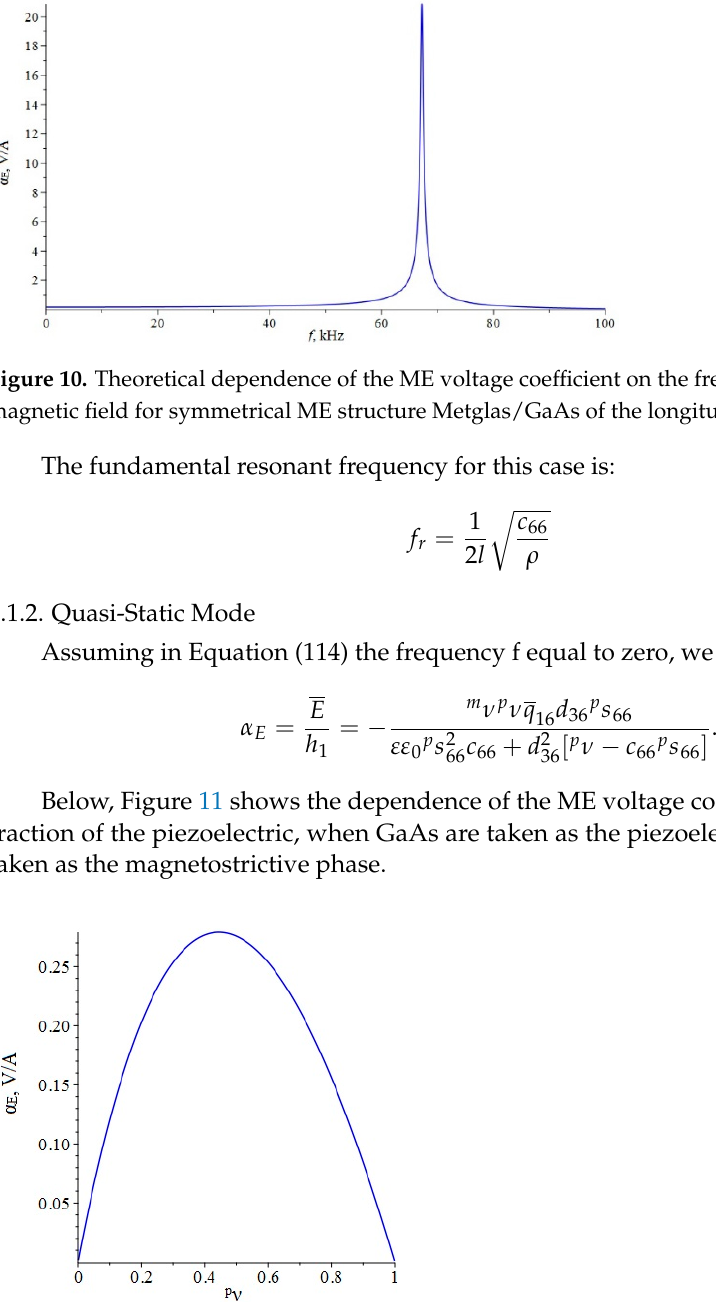
Figure 12. Asymmetric two-layer magnetoelectric composite for calculation of longitudinal-shear mode. All designations are the same as in Figure 9. Below, Figure 13 shows the dependence of the ME voltage coefficient on the fre- quency of the alternating magnetic field. To take into account losses in the calculation, it is assumed: ω = 2 π (1 + (1/2Q)i)f , where Q is the quality factor of the resonant system.